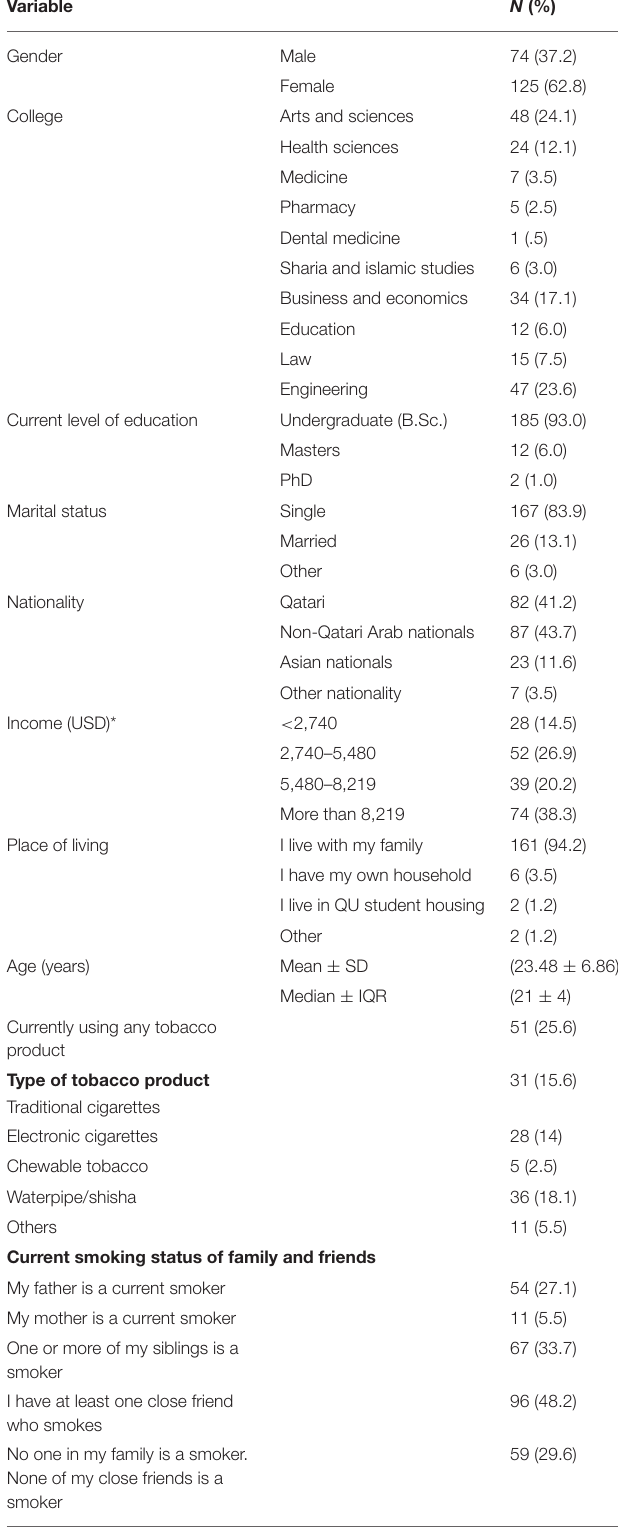
TABLE 1 | Characteristics of